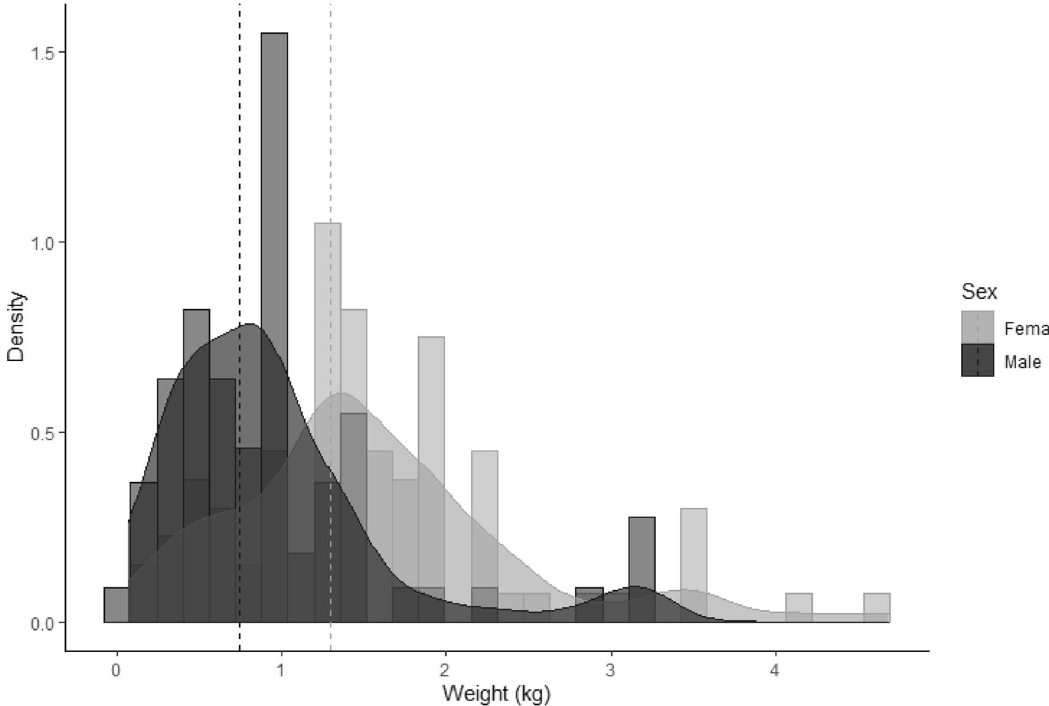
Figure 3. Prey body mass brought into nests by either male (n = 75) or female (n = 92) harpy eagles. Male prey averaged 0.74 kg, while female prey was 57.3% heavier, averaging 1.29 kg (hatched lines). The largest individual prey items brought into a nest were a ~ 4.7 kg lower body of a spider monkey killed by a female, and a ~ 3.2 kg lower body of a howler monkey killed by a